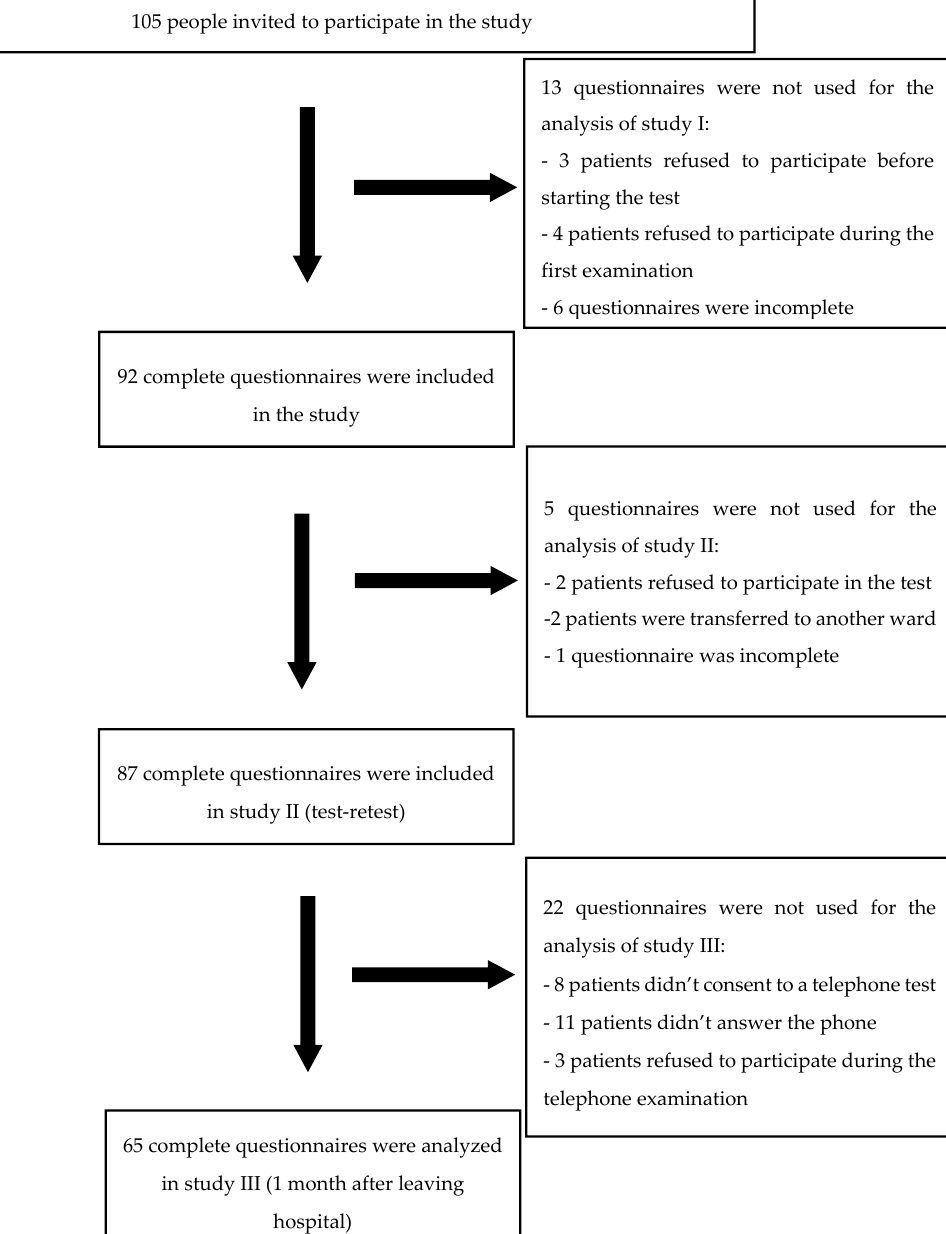
Figure 1. Flow diagram of the study.